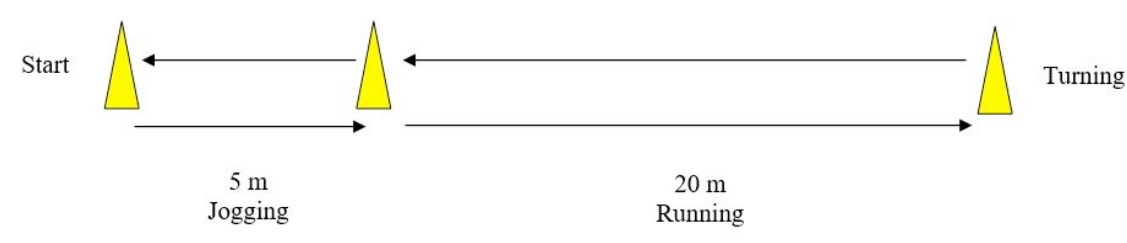
Figure 1. Yo-Yo Intermittent Recovery Level 1 Test Track Table 2. YYIRT1 values of young soccer players at different playing positions Playing Position